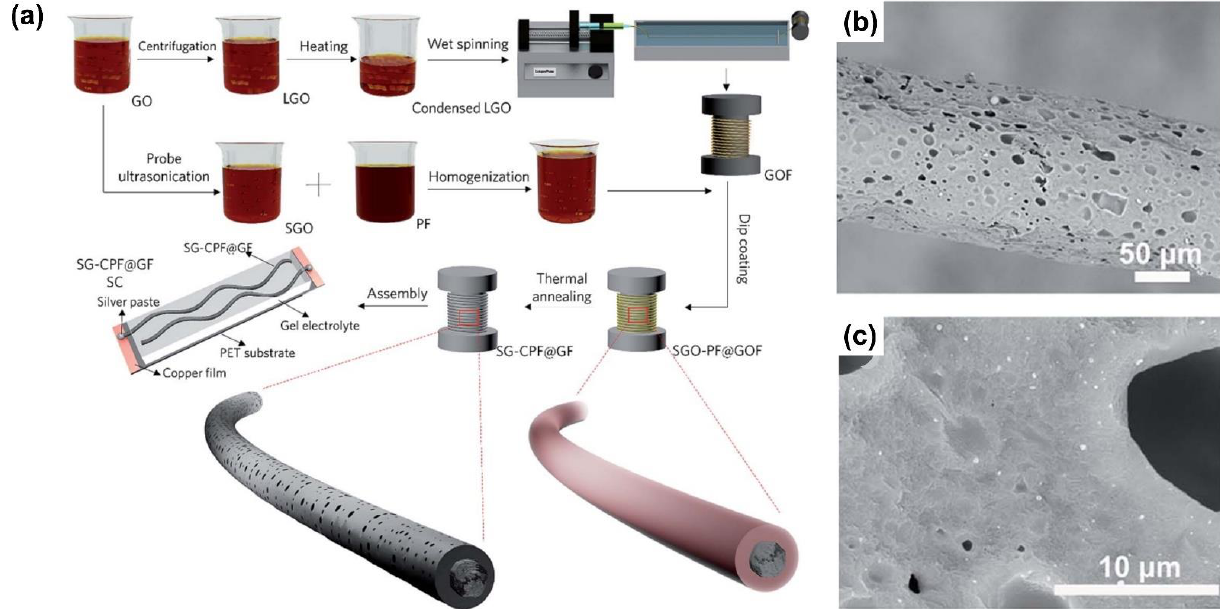
Figure 4. ( a ) Schematic illustration showing the roadmap for producing hierarchically porous core-sheath graphene-based fiber electrodes; ( b,c ) SEM imaging showing the typical porous structure along the fiber axis, confirming the presence of mesopores and macropores [113] (copyright permission Royal Society of Chemistry 2018).